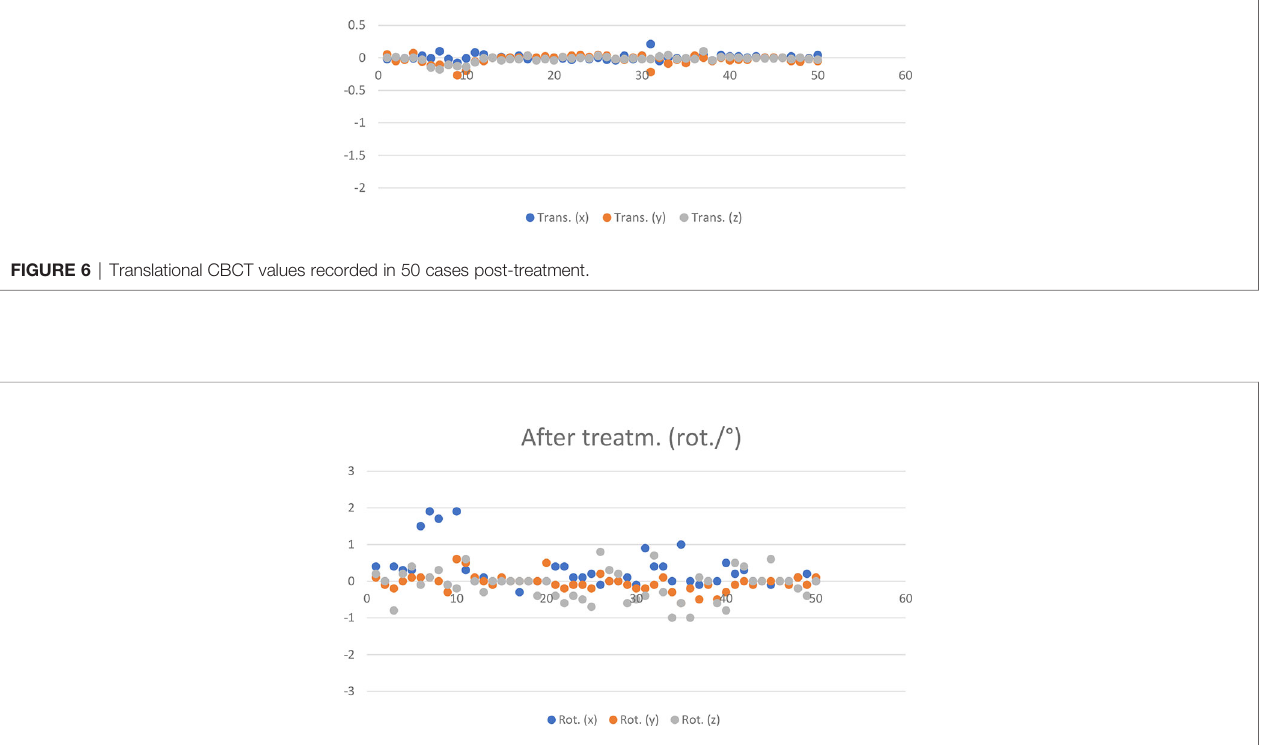
FIGURE 7 | Post-treatment rotational CBCT values recorded in 50 cases.